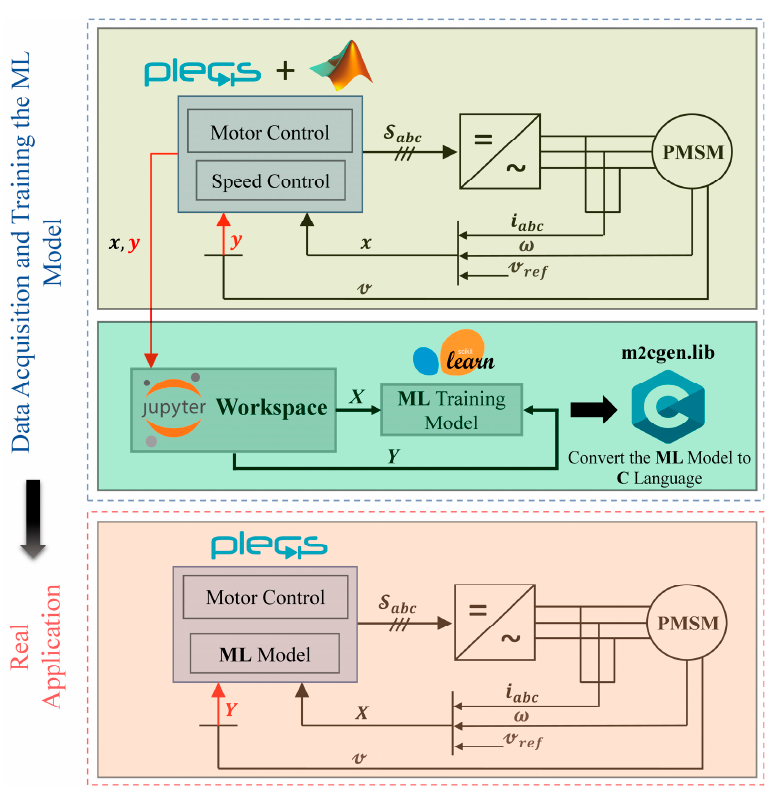
Figure 2. Simplified diagram of the controller design process from data acquisition at the test bench through model training, to the real-time implementation.